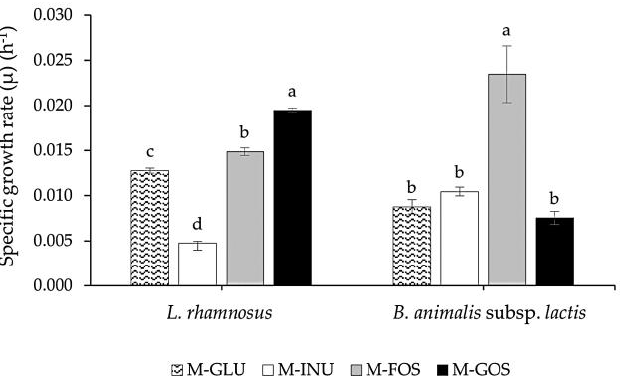
Figure 2. The specific growth rates of L. rhamnosus and B. animalis subsp. lactis in the different mediums supplemented with glucose (control) and prebiotics, for which the various letters showed a significant mean difference ( p < 0.05) in each probiotic strain.